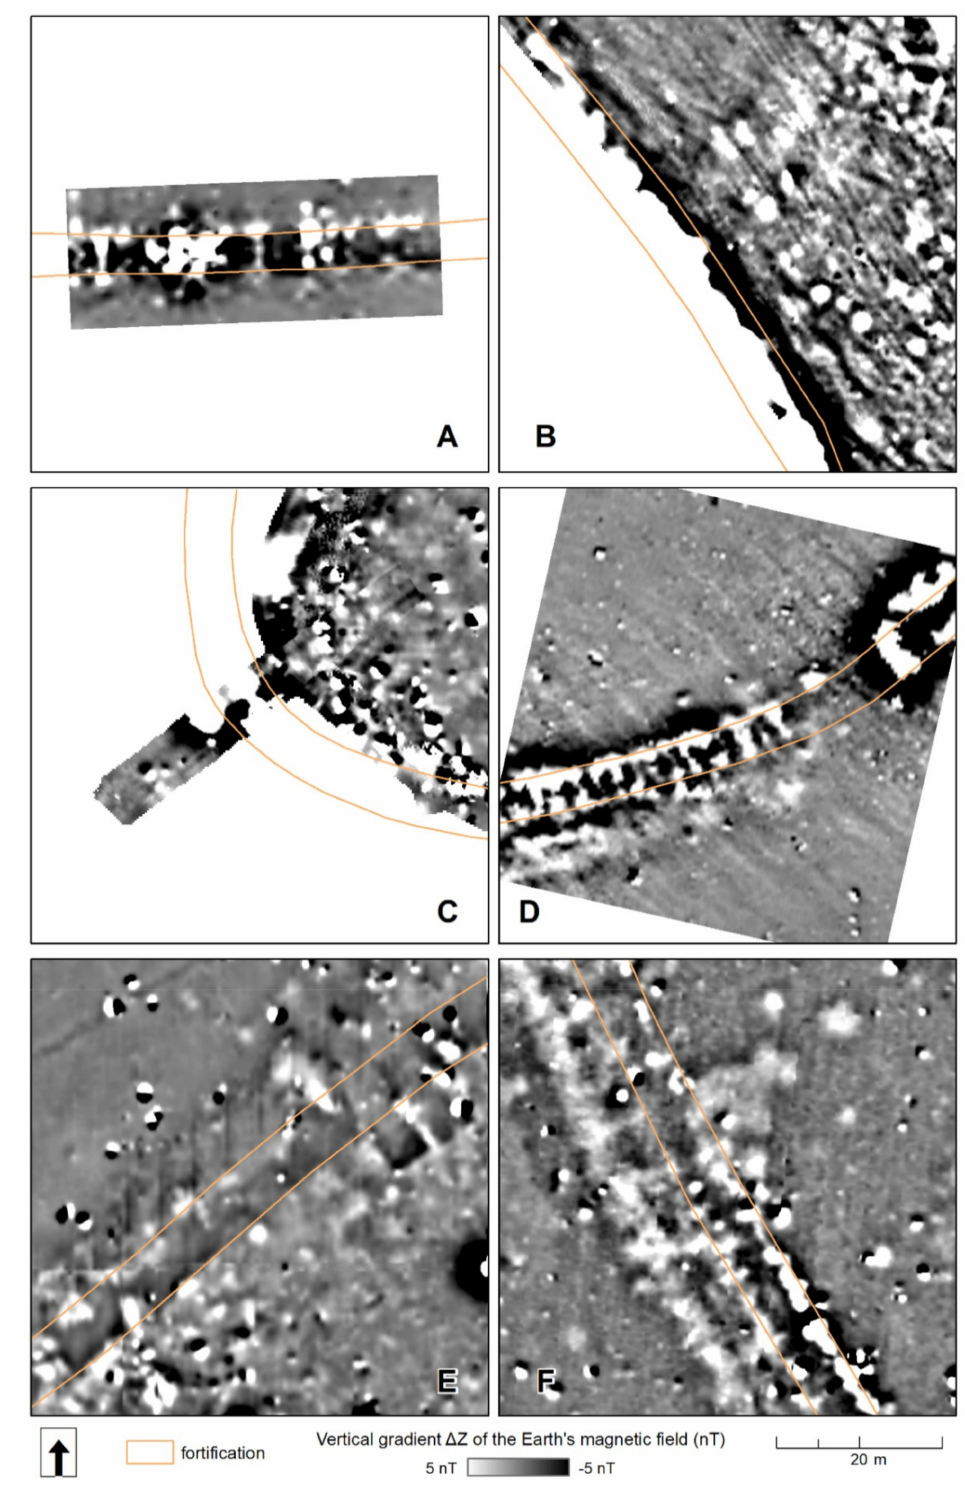
Figure 6. Results of magnetic prospection of fortifications. ( A ): Bˇreclav-Pohansko; ( B ): Brno-Star é Z á mky; ( C ): Doln í Vˇesonice-Vysok á zahrada; ( D ): Majcichov; ( E ): Mikulˇcice; ( F ):